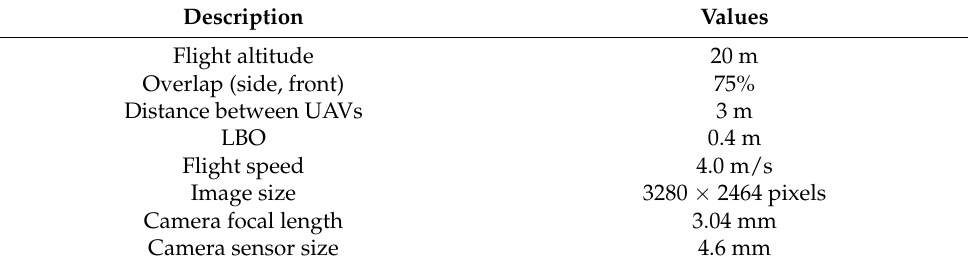
Table 4. Simulation and real field comparison experimental variables.